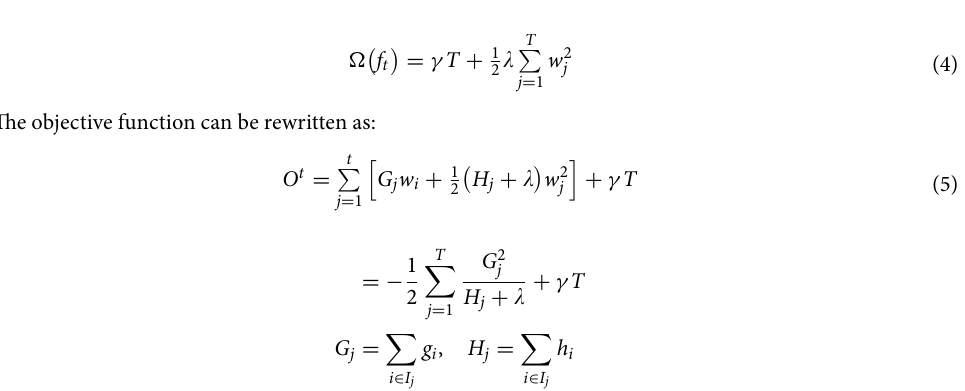
Figure 1. Workflow of